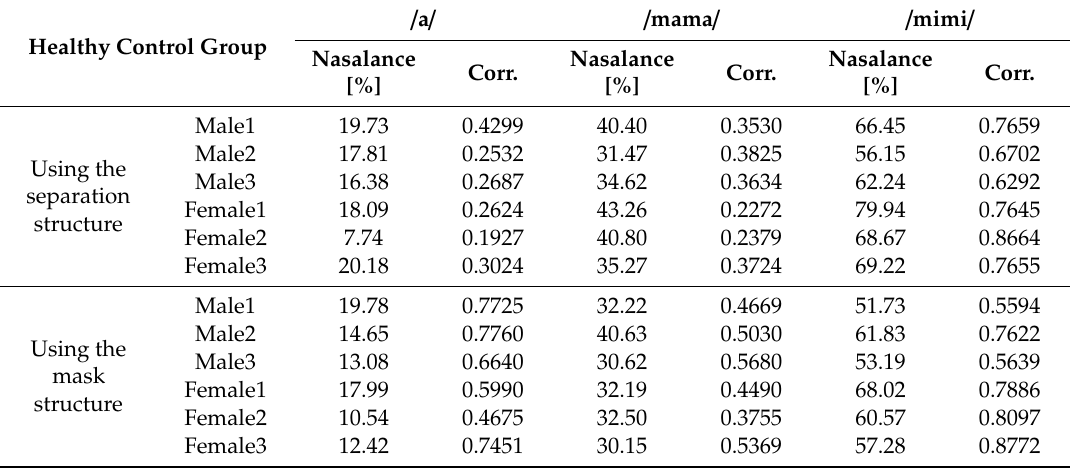
Figure 9. Measured spectrum of vocal signal of females using the separation-type structure for ( a ) /a/, ( b ) /mama/, and ( c ) /mimi/, and measured spectrum of vocal signal of females using the mask-type structure for ( d ) /a/, ( e ) /mama/, and ( f ) /mimi/ (the red line is the microphone output in the oral direction and the blue line is the microphone output in the nasal direction). Table 3. Correlation coe ffi cients and nasalance results of the healthy control